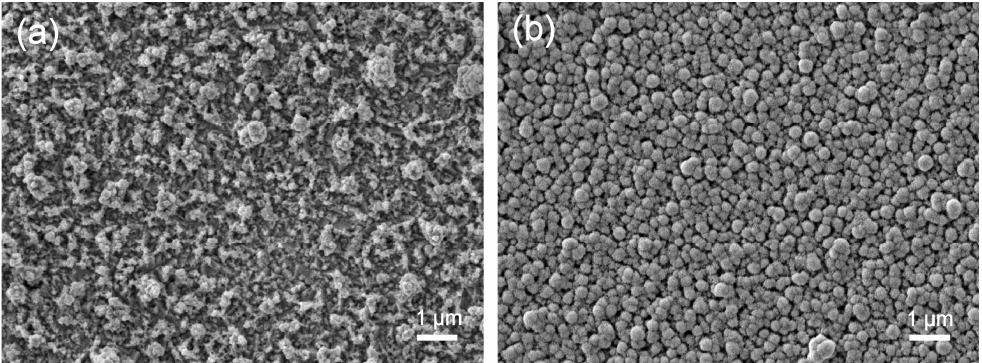
Figure 3. Top-view SEM images of electrodeposited CuFeO 2 films when applying a current density of − 0.2 mA cm − 2 for 60 min in DMSO based electrolytes with different potassium perchlorate concentrations: ( a ) Solution #1 containing 1 mM Cu(NO 3 ) 2 ∙ xH 2 O/3 mM Fe(ClO 4 ) 3 ∙ xH 2 O/100 mM potassium perchlorate and ( b ) Solution #2 containing 4 mM Cu(NO 3 ) 2 ∙ xH 2 O/12 mM Fe(ClO 4 ) 3 ∙ xH 2 O/50 mM potassium perchlorate. Electrodeposited films were annealed at 650 °C for 1 h under N 2 gas flow.